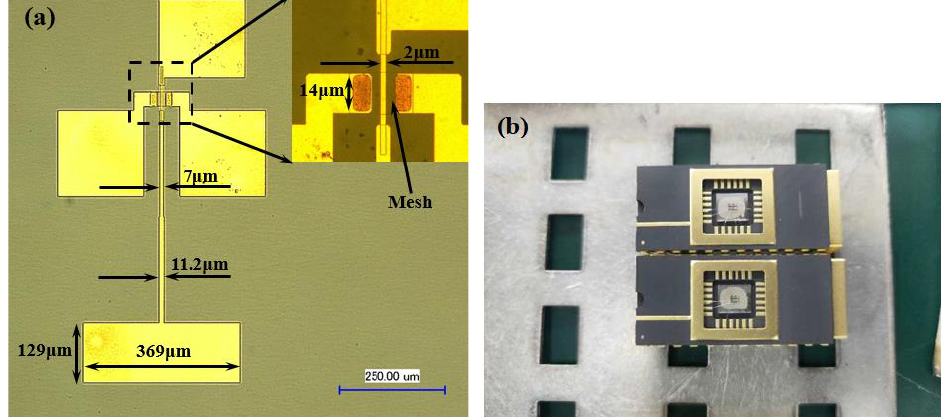
Figure 6. ( a ) Top view of the prepared DC GaN HEMT detector integrated with microstrip patch antenna. ( b ) THz chips packaged by DIP24 ceramic shell.